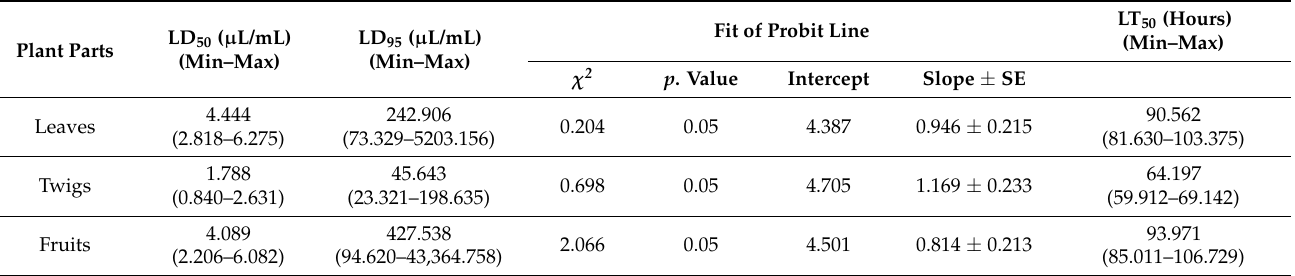
Table 5. Fumigant toxicity of three essential oils (leaves, twigs, and fruits) from Eucalyptus gunnii on adult Callosobruchus maculatus after 96 h.